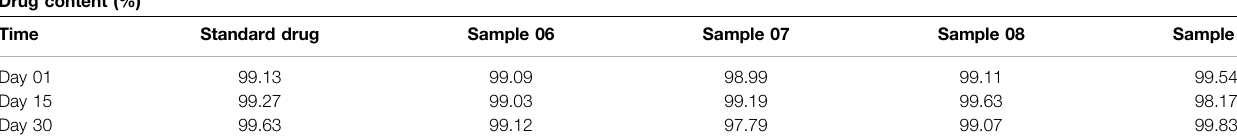
TABLE 3 | Result of drug content